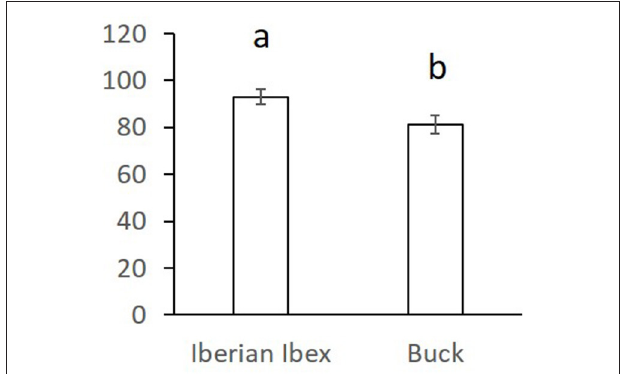
FIGURE 3 | Stress resistance factor (SR) (mean ± SE) for curvilinear velocity (VCL) after refrigeration at 15 ◦ C during 20h and subsequent incubation at 38.5 ◦ C for 2h in ibex and buck sperm samples. Means within different letters are significantly different ( p < 0.05) between species.